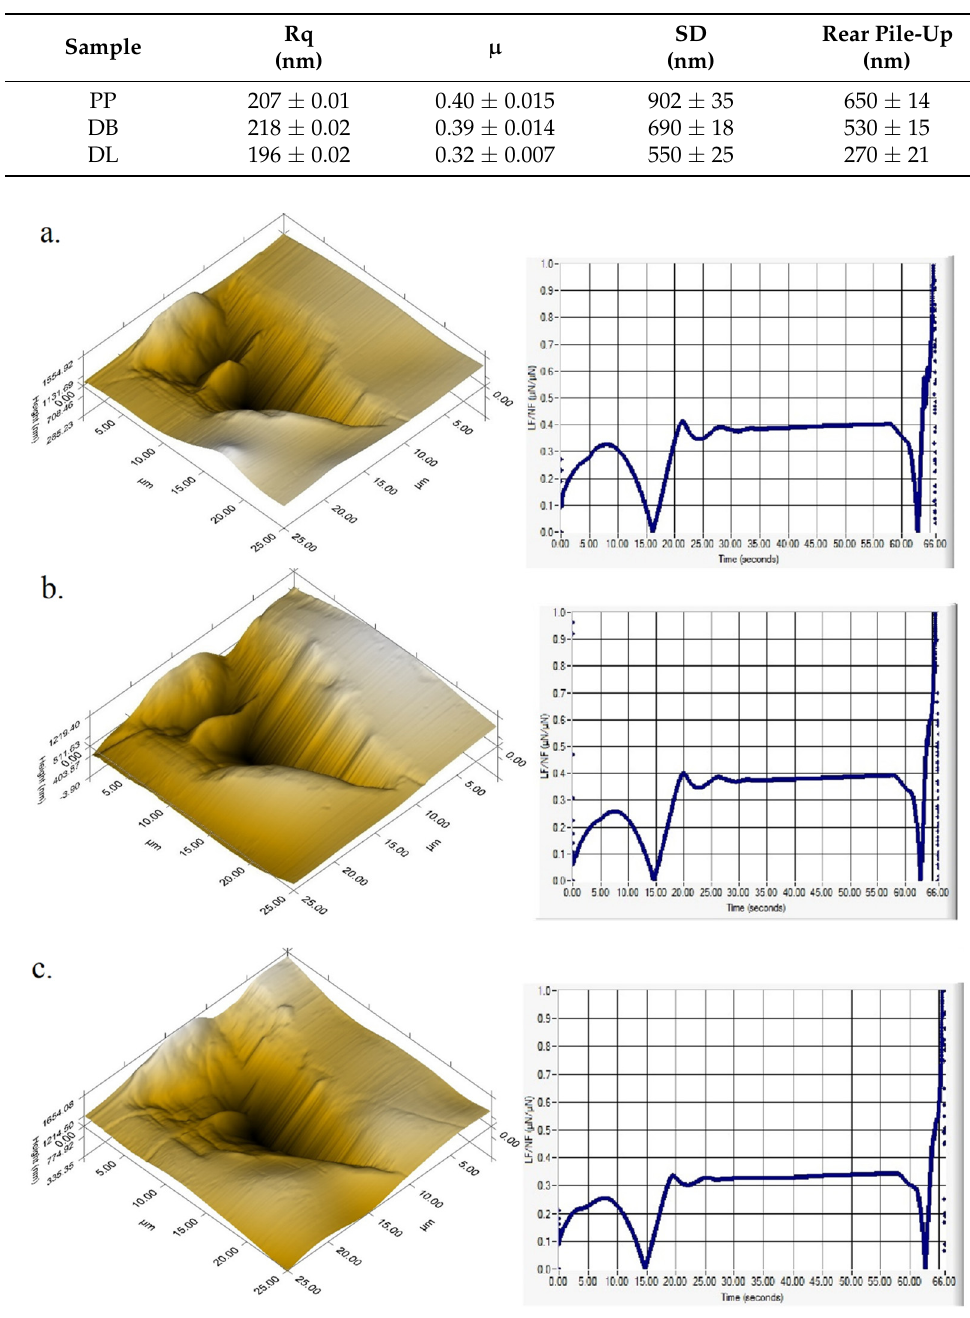
Figure 15. 3-D topographical in situ SPM images (top) and the apparent friction coefficient (bottom), defined as the ratio between the lateral force and the applied load, obtained on PP ( a ), DB composite ( b ) and DL composite ( c ). The topographic images show a different scratching behavior for the three samples.